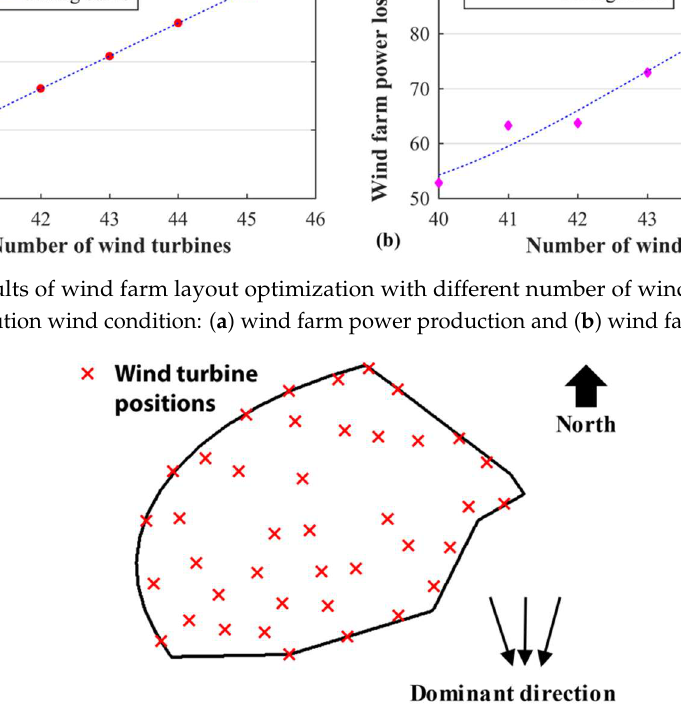
Figure 13. Optimal wind farm layout with 40 wind turbines under Weibull distribution wind condition.